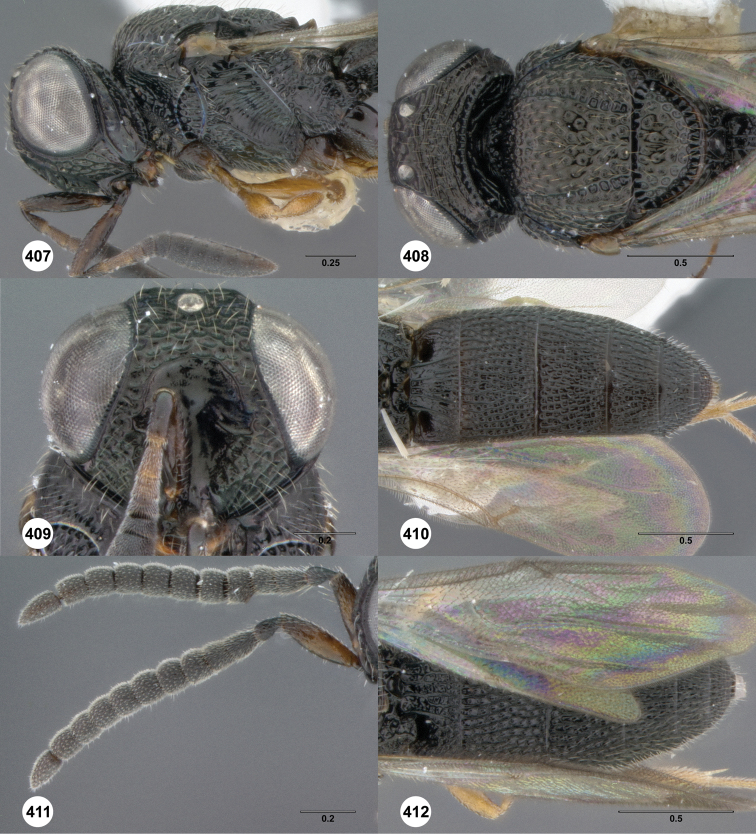
Oxyscelio wa sp. n., holotype female (OSUC 449005) 407 Head and mesosoma, lateral view 408 Head and mesosoma, dorsal view 409 Head, anterior view. Paratype female (OSUC 449009) 410 Metasoma, dorsal view. Paratype male (OSUC 449019) 411 Antenna 412 Metasoma, dorsal view. Morphbank105